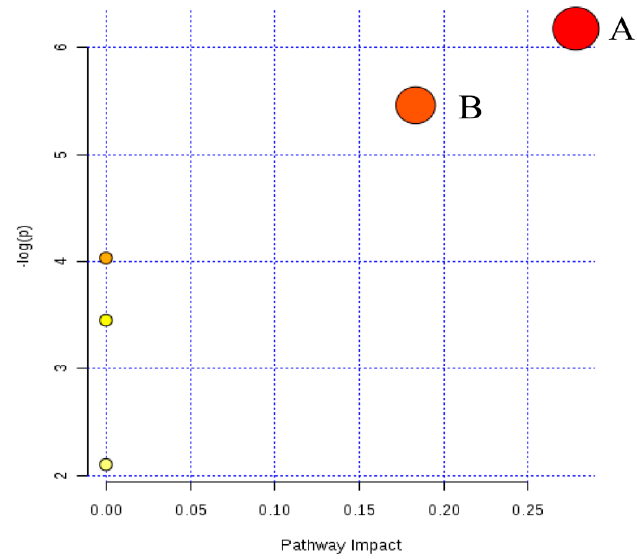
Figure 9. Summary of the pathway analysis with MetPA. ( A ) Glycerophospholipid metabolism; ( B ) sphingolipid